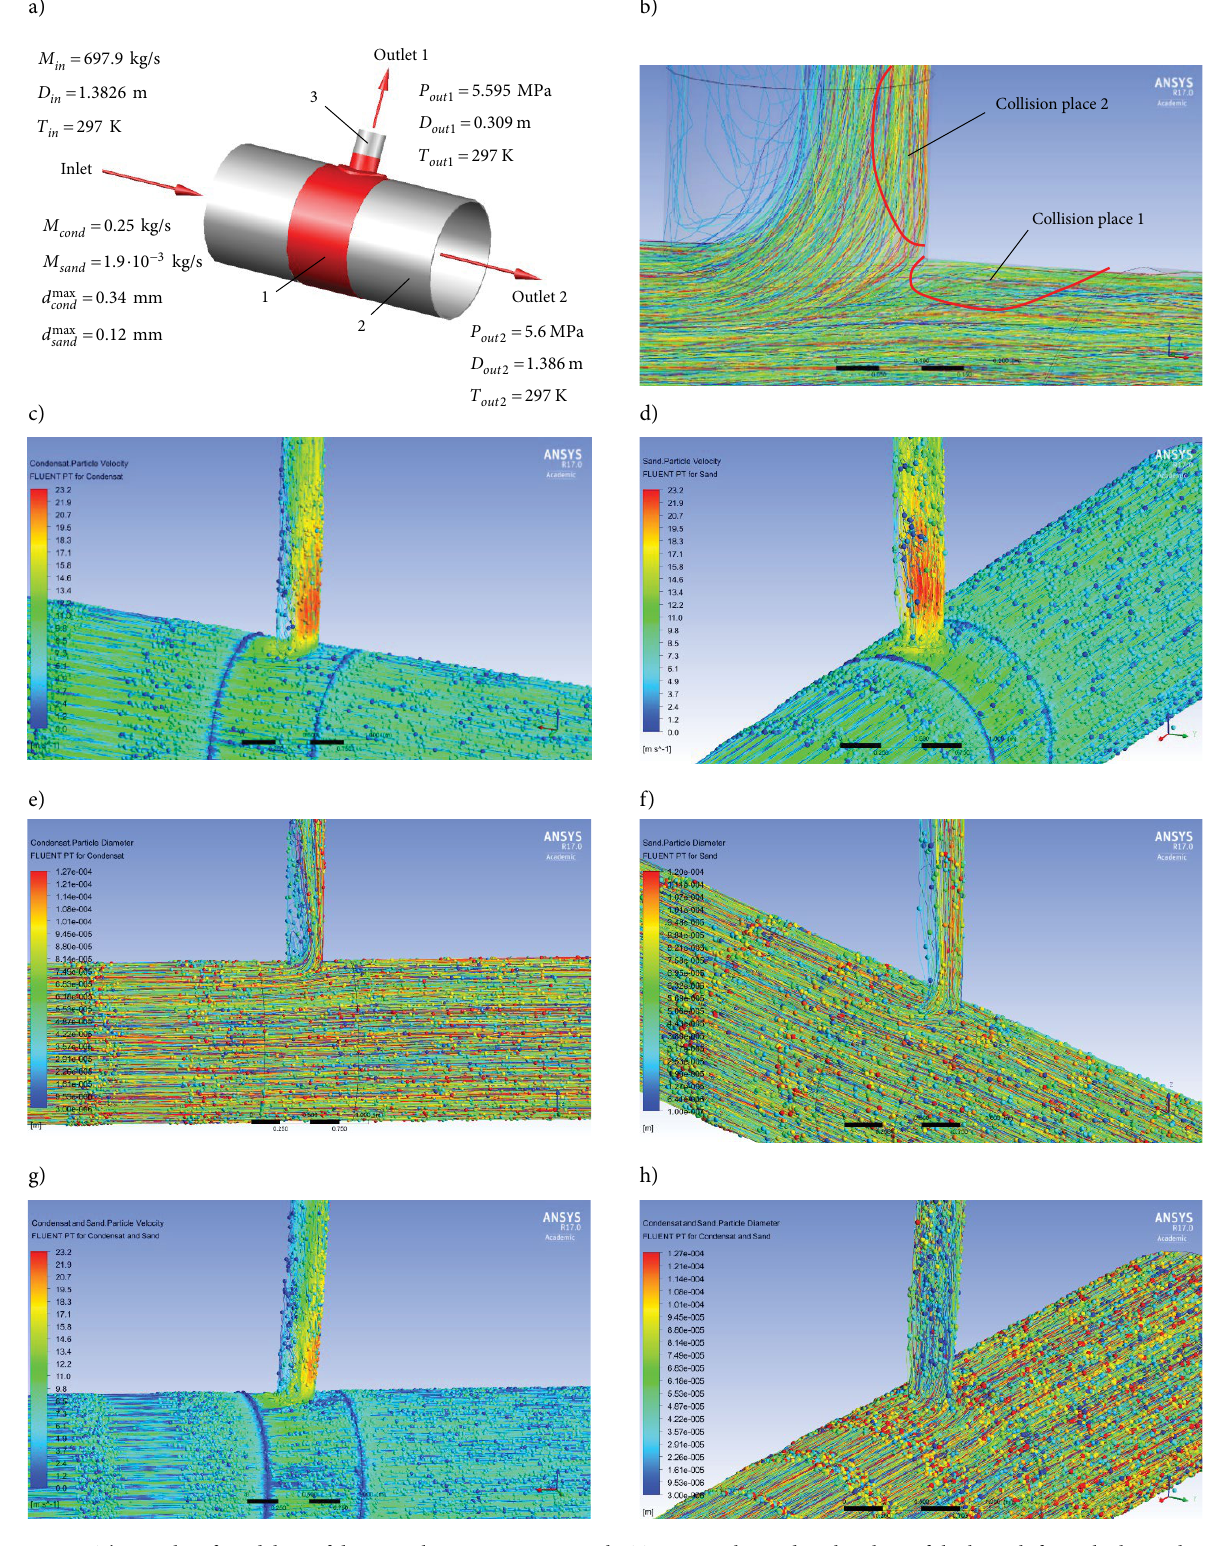
Figure 4. The results of modeling of discrete phases movement in the T-junction located in the place of the branch from the line, where gas moves in the T-junction run-pipe, and part of the flow is directed to the T-junction branch: 1 – welded T-junction with reinforcing plate 1420 × 20…325 × 9 mm (Standard OST 102-61-81); 2 – pipe 1420 × 18.7 mm; 3 – pipe 325 × 8 mm; a – calculation scheme; b – trajectories of discrete phases; c –trajectories of condensed droplets painted in colors that match the velocity; d – trajectories of solid particles painted in colors that match the velocity of particles; e – trajectories of condensed droplets painted in colors that match the diameter of droplets; f – trajectories of solid particles painted in colors that match the diameter of particles; g – trajectories of discrete phases movement painted in colors that match the velocity; h – trajectories of discrete phases movement painted in colors that match the diameter of droplets and